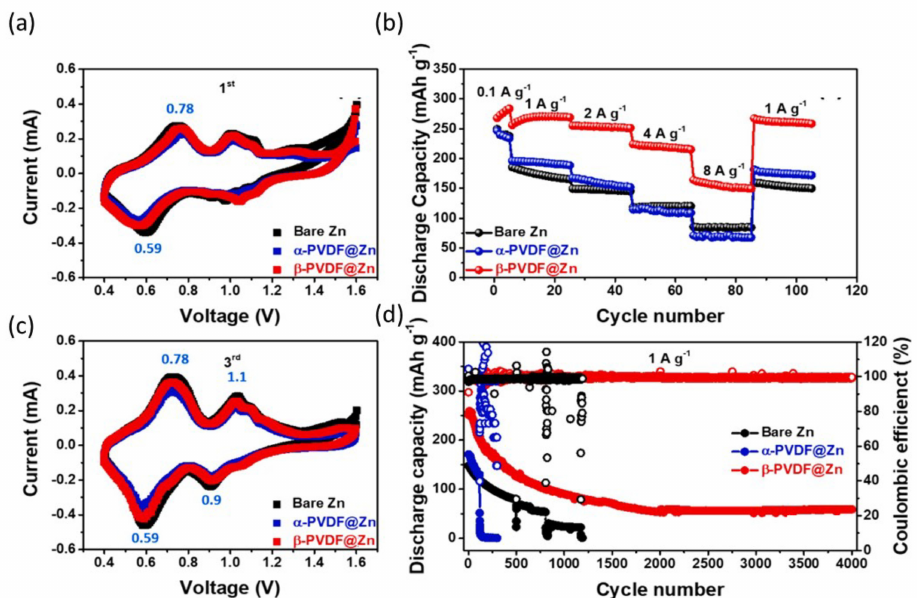
Figure 16. Electrochemical performance of β -PVDF@Zn (red), α -PVDF@Zn (blue), and bare Zn (black) full cells with V 2 O 5 /C cathode: first ( a ) and third ( b ) CV curves at 0.2 mV s − 1 from 0.4 to 1.6 V. Rate performance ( c ) at various current densities of 0.1, 1, 2, 4, 8, and 1 Ag − 1 , and long-term cycling performance ( d ) at a current density of 1 Ag − 1 . Reprinted with permission from Ref. [103]. Copyright 2021 American Chemical